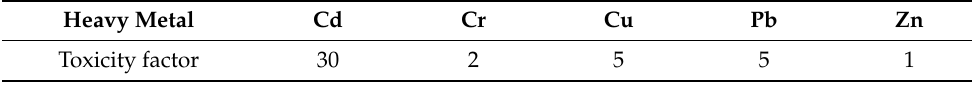
Table 3. Toxicity coefficient of heavy metals.